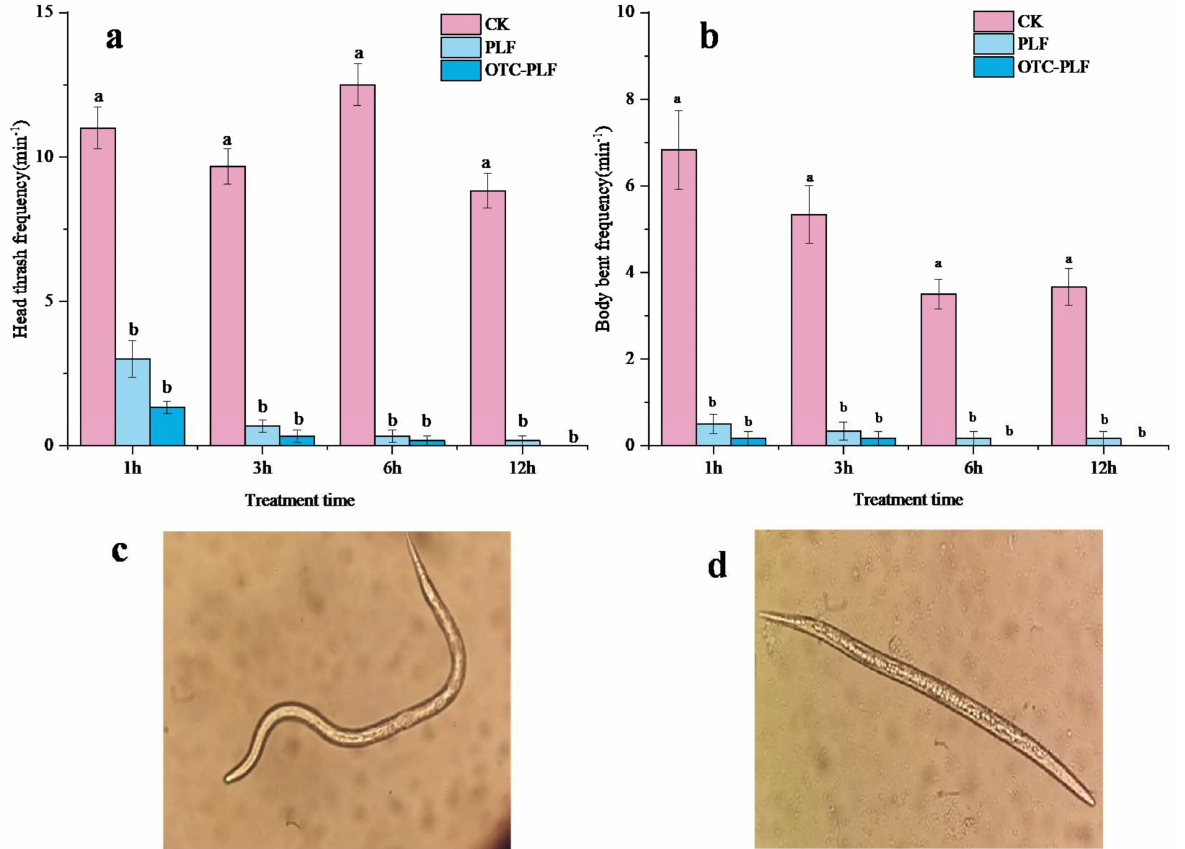
Figure 3. Effect of culture filtrates (OTC-PLF and PLF) on J2s locomotion behavior. OTC-PLF represents the culture filtrates of Purpureocillium lilacinum combined with by 6-oxychitin. PLF represents the culture filtrates of Purpureocillium lilacinum . CK represents the blank control. ( a , b ) are the body bent and head thrash frequency of the M. incognita that survived within 12 h, respectively. The state of ( c ) surviving and ( d ) dead nematodes. Different letters represent significant differences ( p < 0.05) according to Duncan’s